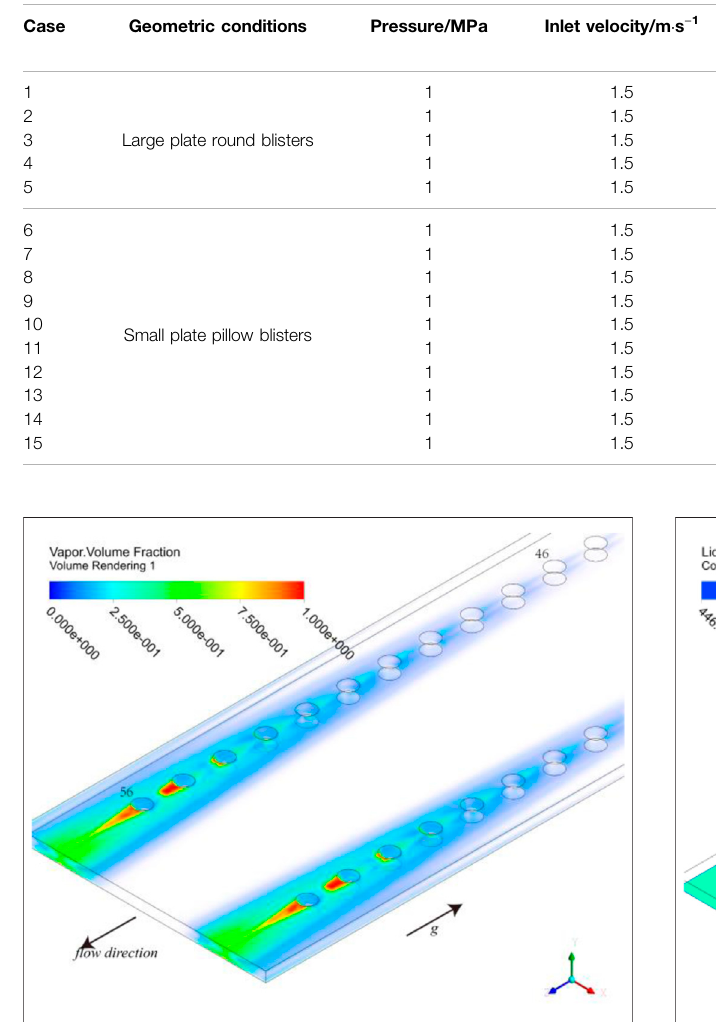
TABLE 2 | Operating conditions simulated in this study.